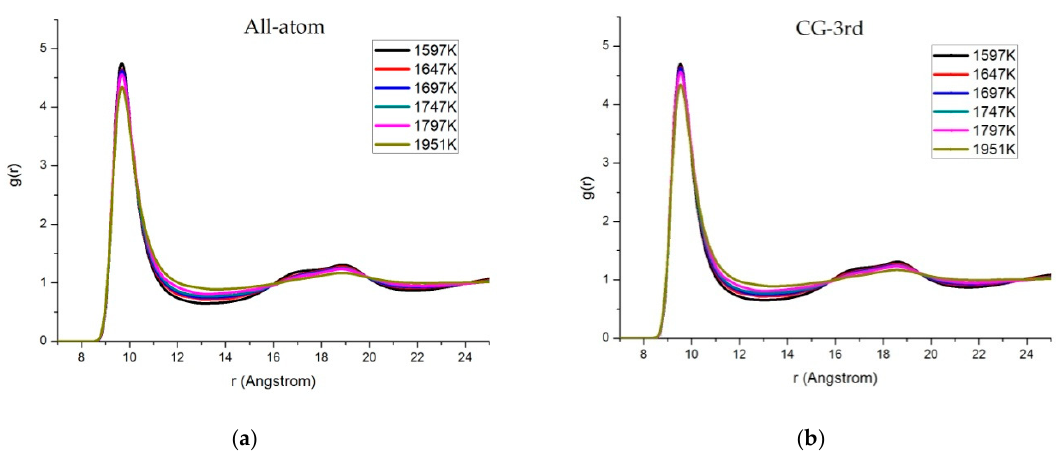
Figure 7. Temperature effect of RDFs for ( a ) the all-atom model and ( b ) the third-order CG model.